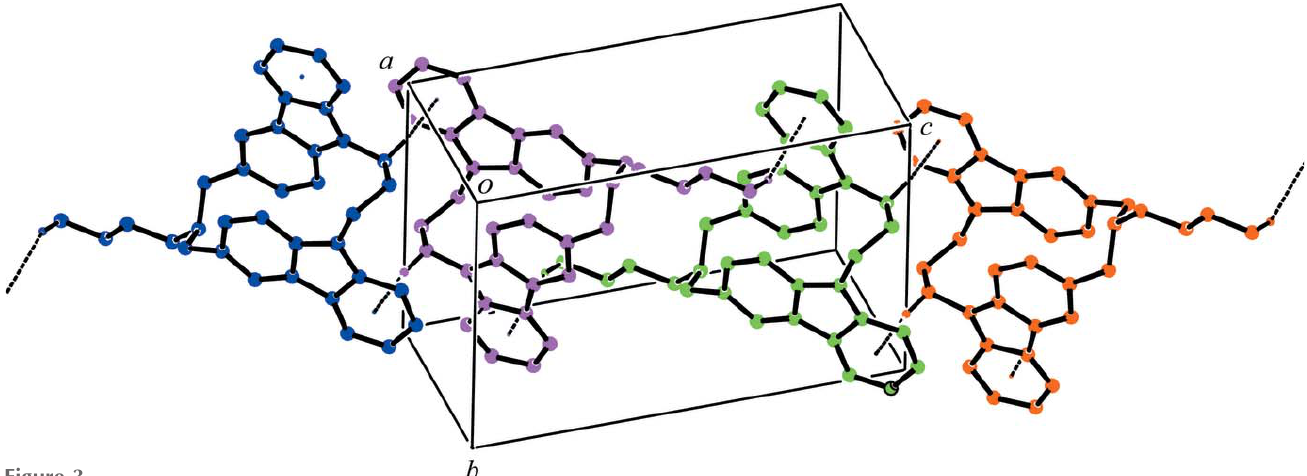
Figure 3 An excerpt of the crystal packing of the title compound showing the ribbon structure along [101]. The C—H (cid:2)(cid:2)(cid:2) (cid:2) interactions are shown as black dashed lines. H atoms not involved in these interactions have been omitted for clarity.